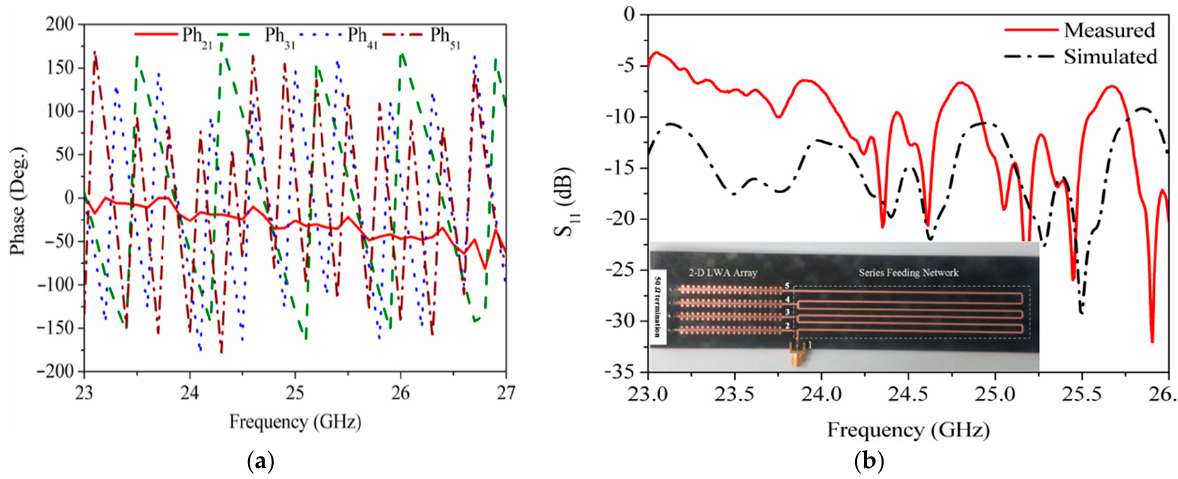
Figure 23. Layout of 2D MTM LWA array at 24 GHz band [52].